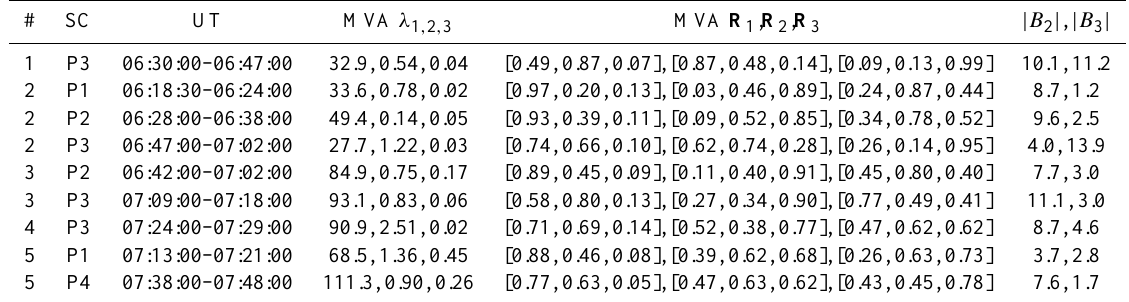
Table 1. Minimum Variance Analysis of the magnetic field time series during current sheet crossings: the crossing number (#); the probe used (SC); MVA eigenvalues ( λ 1 , λ 2 , and λ 3 ; the corresponding eigenvectors ( R 1 , R 2 , R 3 ) in GSM (excluding for signs); mean values of intermediate ( B 2 ) and normal ( B 3 ) components of the magnetic field during the